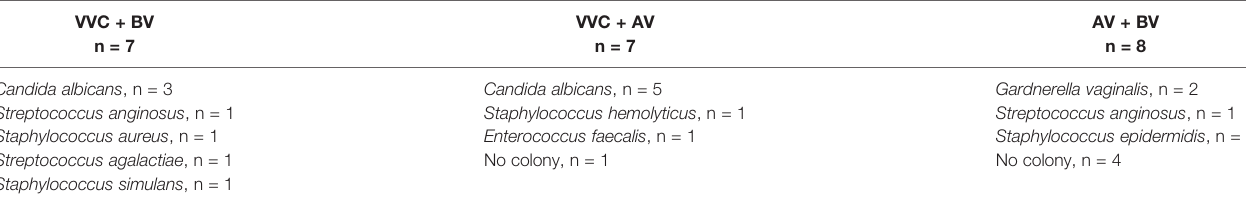
TABLE 4 | Microbial isolation of pathogens in mixed vaginitis during late